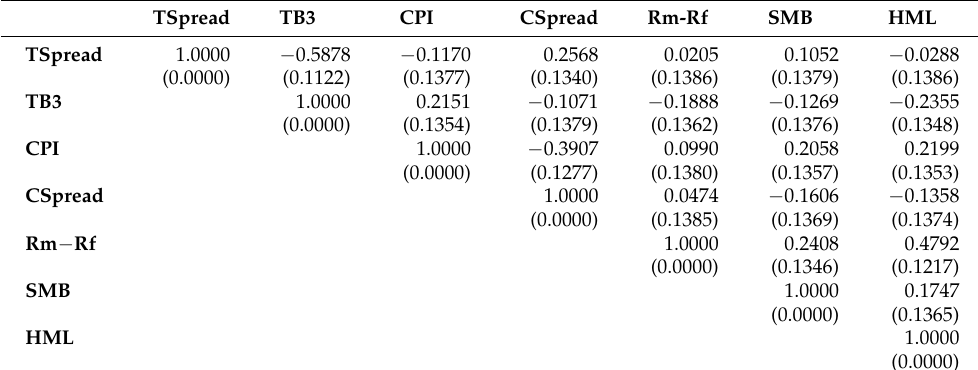
Figure 2. Macro/Asset Pricing Variables. Table 2. Correlation Coefficients among Asset Pricing/Macro Control